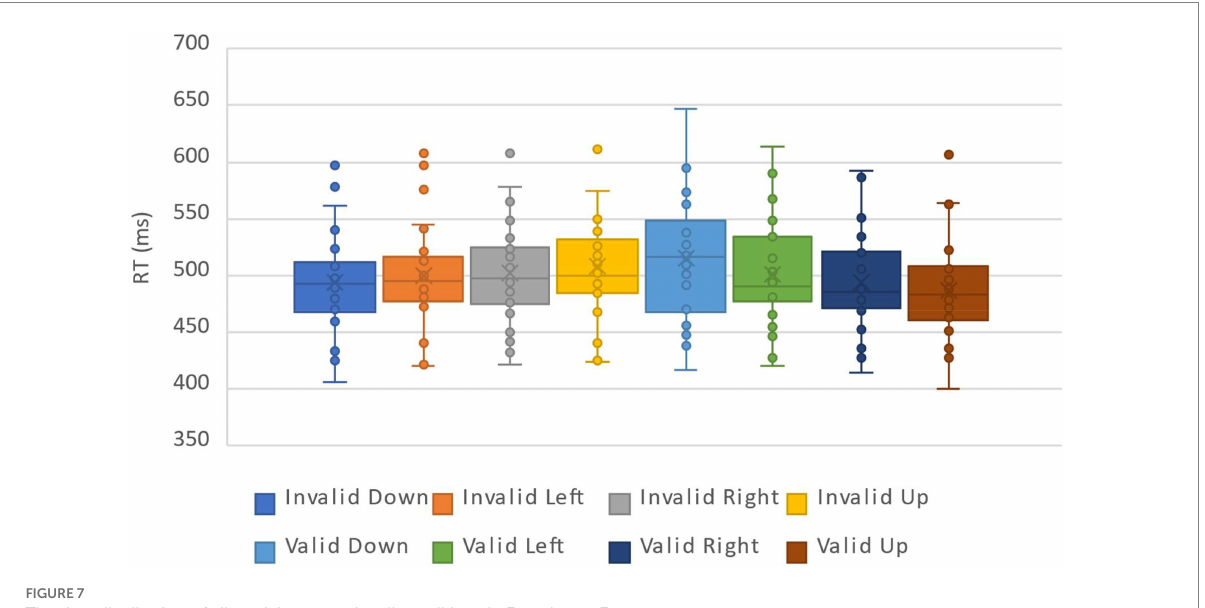
FIGURE 7 The data distribution of all participants under all conditions in Experiment 3.